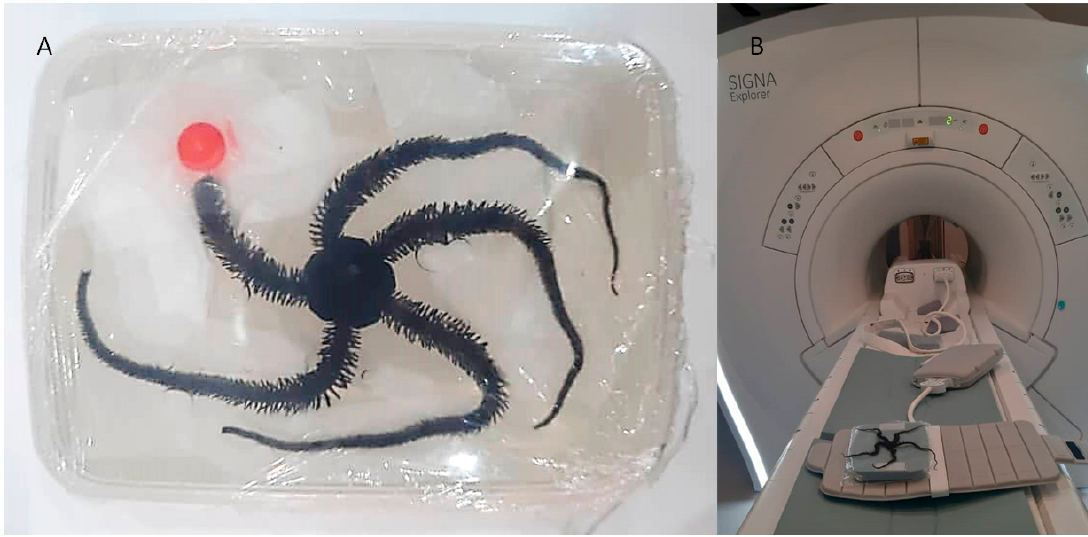
Figure 10. Procedure of MRI imaging of brittle star. ( A ) The brittle star was placed in a plastic container (10 cm × 15 cm × 5 cm) for MRI procedures. ( B ) The SIGNA 1.5 T MRI portfolio and Flex coil for arm imaging were used for MRI procedures.